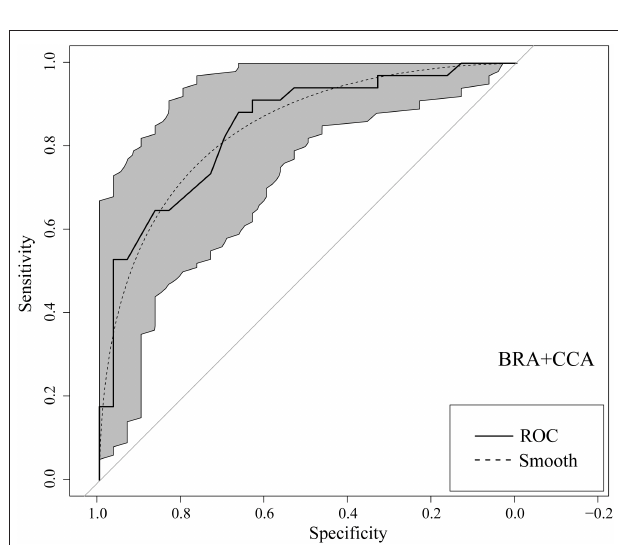
FIGURE 3 | Receiver Operating Characteristic (ROC) curve (solid line) for BRA + CCA (Climate Change Assessment) of the non-native freshwater fish species screened with the Aquatic Species Invasiveness Screening Kit (AS-ISK) for Turkish freshwaters. Smoothing line and confidence intervals of specificities (gray area) are also provided. The raw data analyzed is taken from Tarkan et al. (2017a).